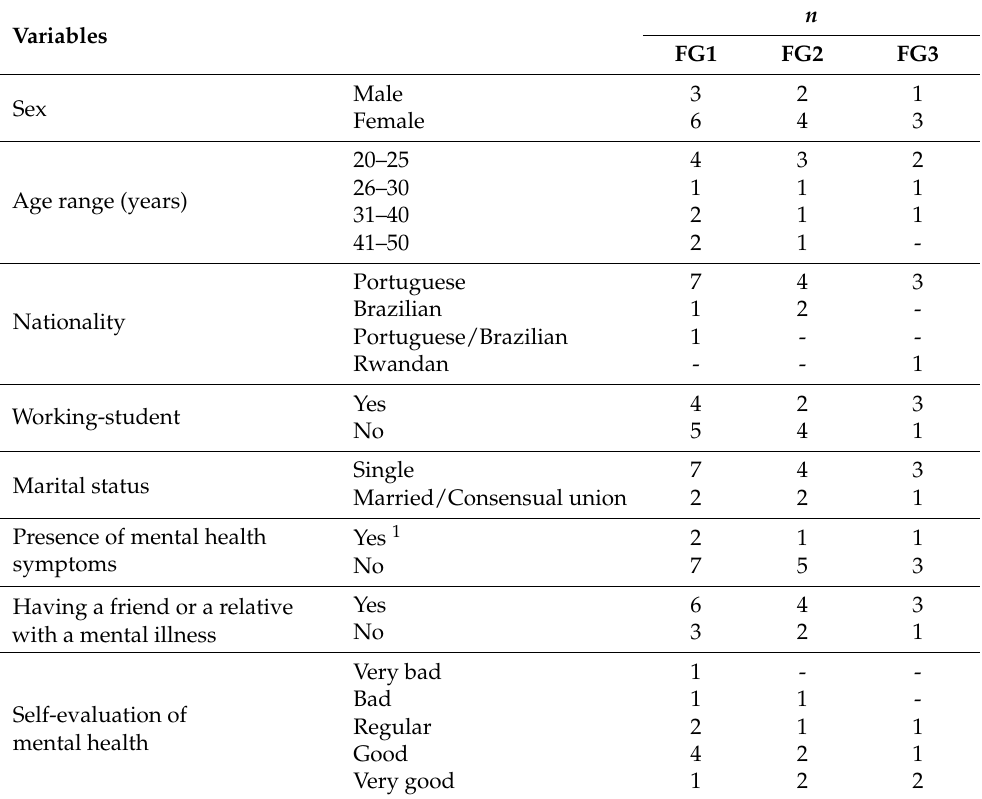
Table 2. Demographic characteristics of the